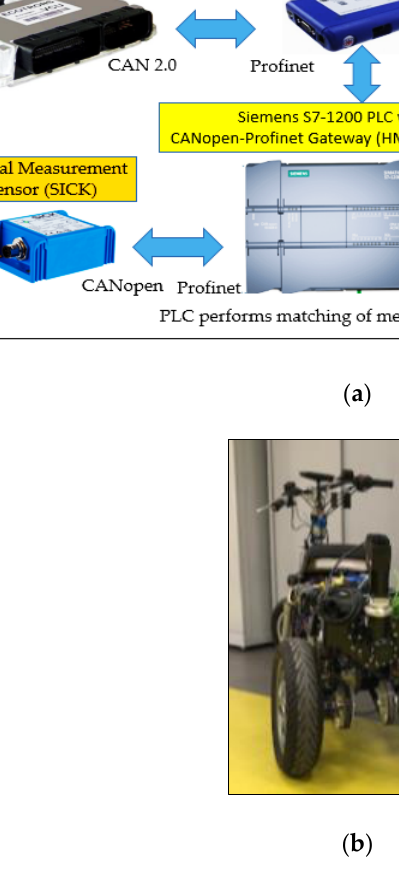
Figure 9. ( a ) Components of tilt control system used in experimental setup; ( b ) prototype three wheeled electric vehicle. wheeled electric